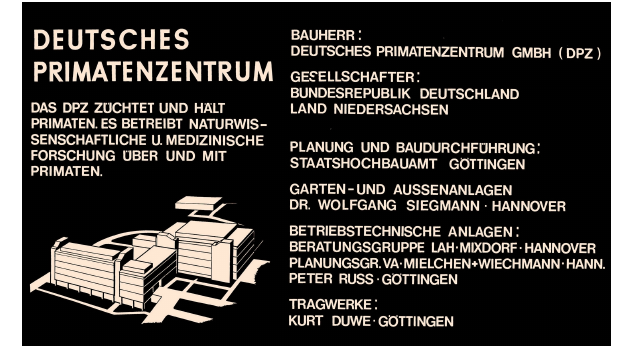
Figure 8. The information panel from the State Construction Au- thority. The foundation stone was laid on 11 May 1979 (picture from DPZ archive).